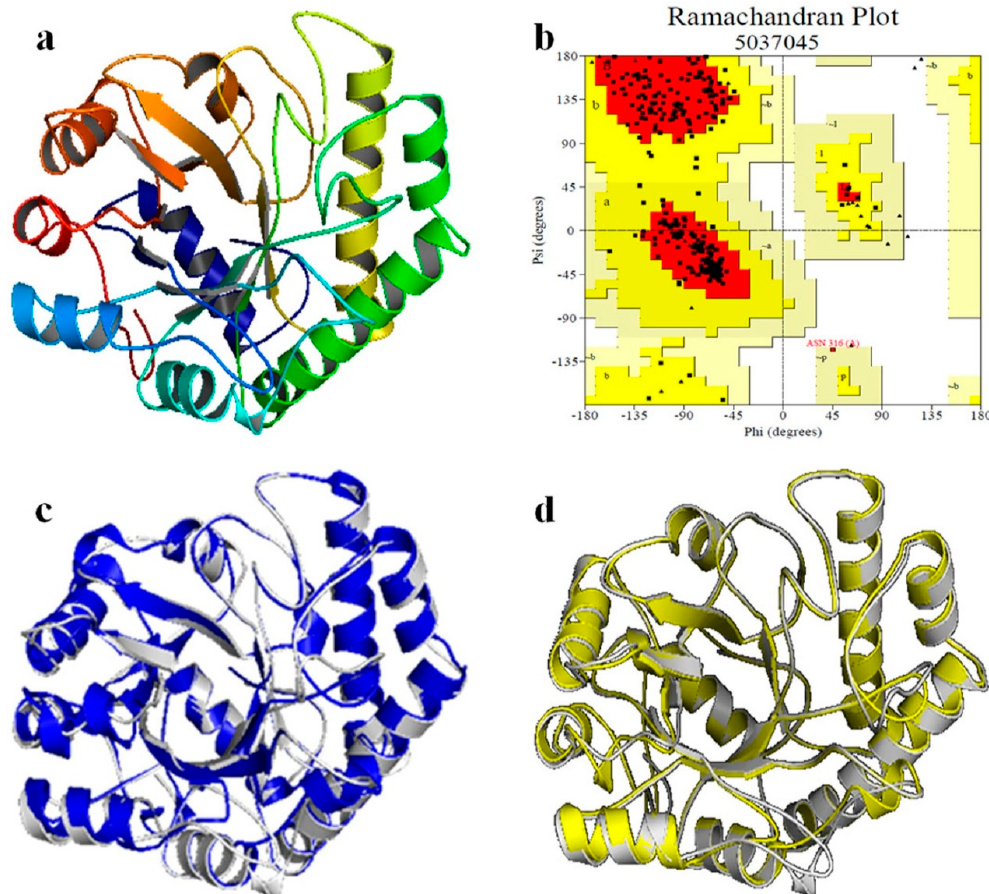
Figure 2. Homology modeling of β -mannanase of Man26E. ( a ) The predicted 3D-structure of Man26E based on B. subtilis β -mannanase (2WHK_A). The figure was generated using the program SWISS-MODEL and the software PyMol 2.3.2; C-terminus (bright blue ), N-terminus ( red ); ( b ) Ramachandran plot of the homology-modeled structure of Man1E based on B. subtilis β -mannanase; ( c ) the overlap between Man26E (represented in gray) and BCman (represented in blue); ( d ) the overlap between Man26E (represented in gray) and BsMan26A (represented in yellow).